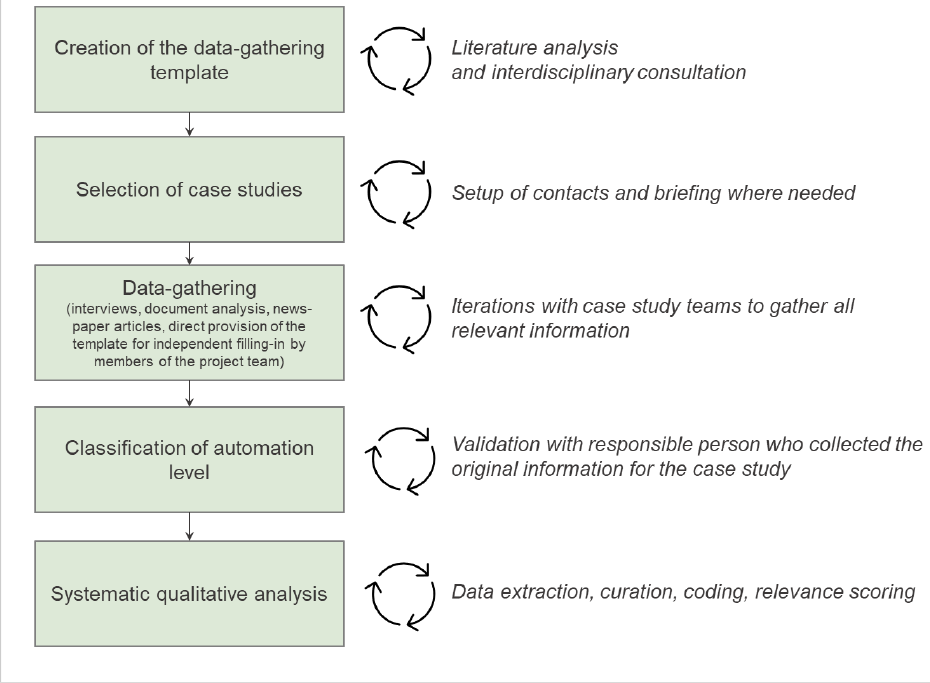
Figure 1. Research process of template creation, case study selection, data-gathering, classification of automation level, systematic qualitative